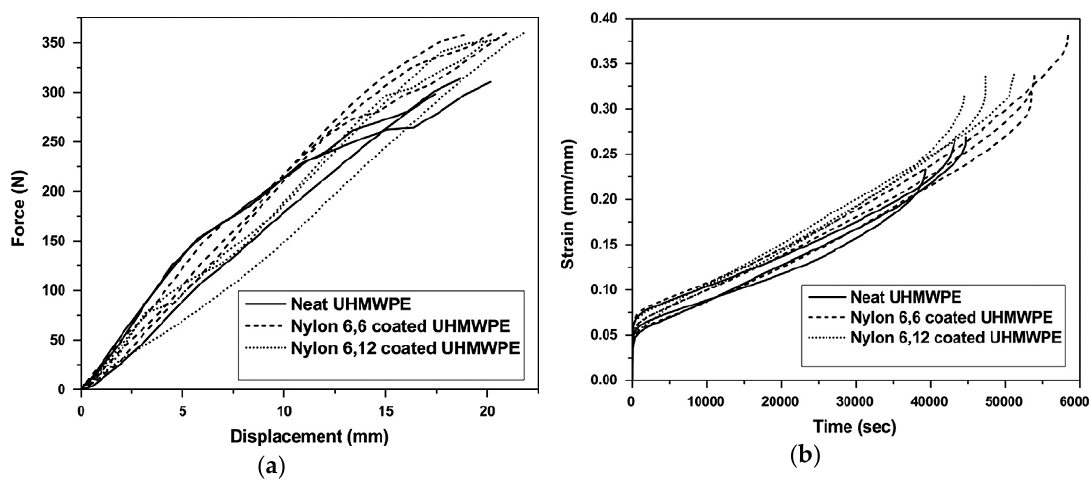
Figure 9. ( a ) Tensile test results of pure and nylon coated UHMWPE fibers at 25 °C ( b ) Creep test results of pure and nylon coated UHMWPE fibers at 25 °C. Reprinted with permission from [160].